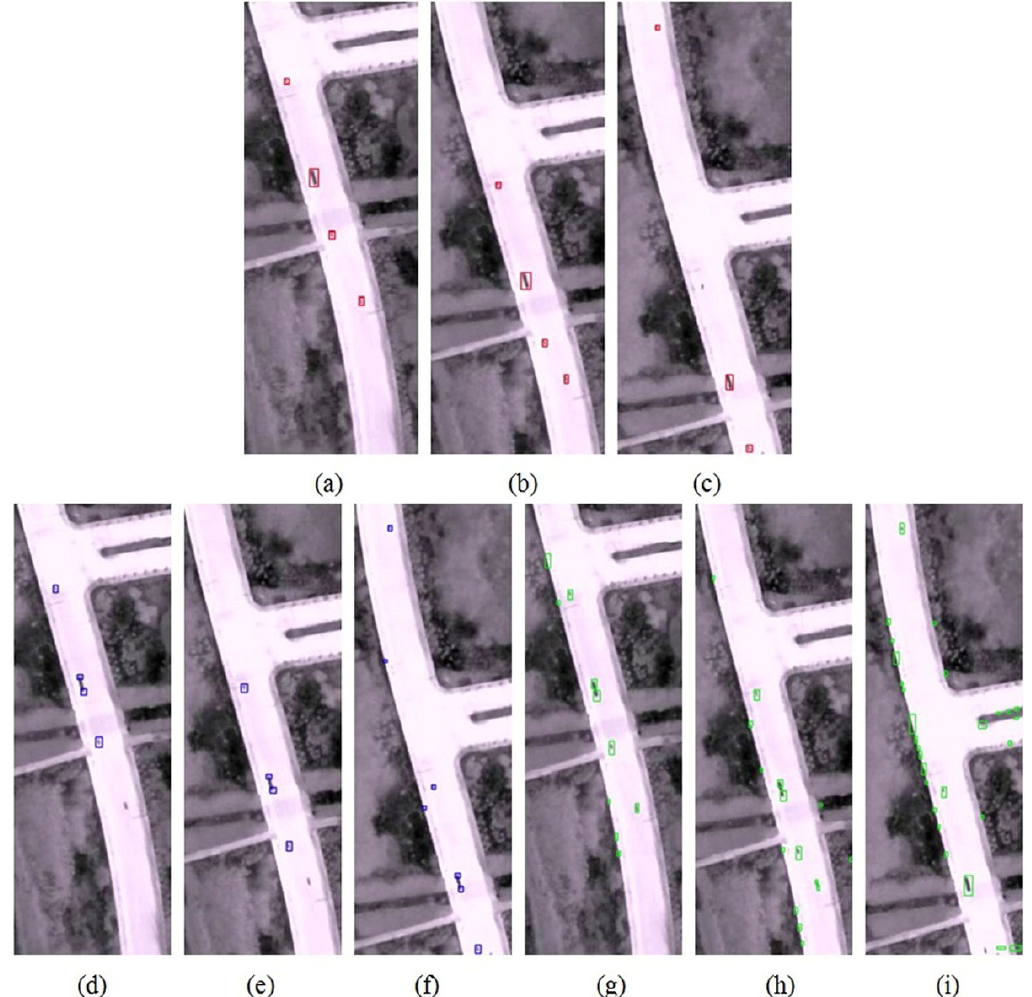
Figure 7. Target detection results for Sequence C. The area range for the detectable targets was set from 9 pixels to 200 pixels. Red rectangles are used in parts ( a – c ) respectively to represent the results obtained using SFDLC for the 10th, 55th and 100th frames; blue rectangles are used in parts ( d – f ) to represent the corresponding results obtained using SFD; and green rectangles are used in parts ( g – i ) to represent the corresponding results obtained using AFD.